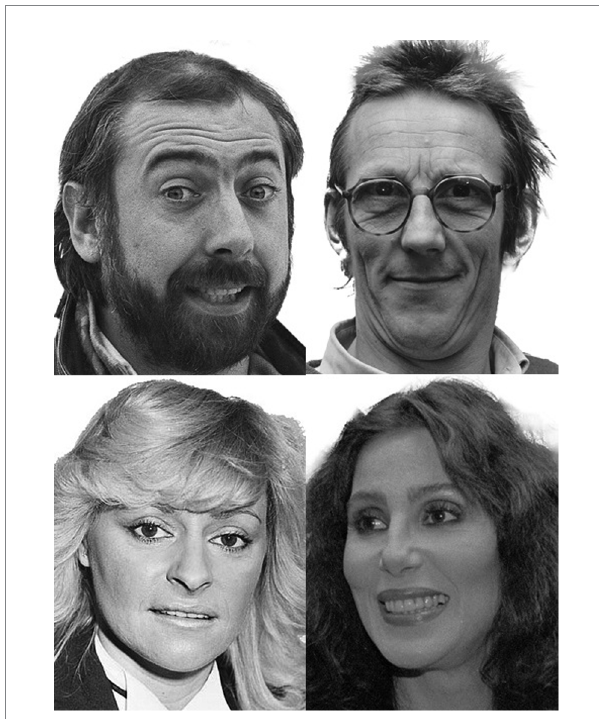
FIGURE 3 Examples of test material of the D-FFT. The famous faces depicted here are part of the practice trial in steps 4 and 5 and are not included in the nine D-FFT versions. These photographs have a CC0 license (https://creativecommons.org/share-your-work/public- domain/cc0/) or are in the Public Domain and do therefore not require a consent